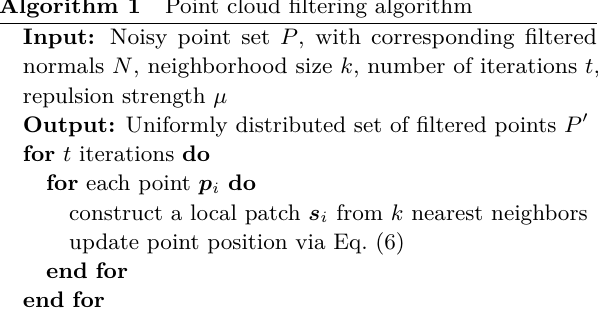
Algorithm 1 Point cloud filtering